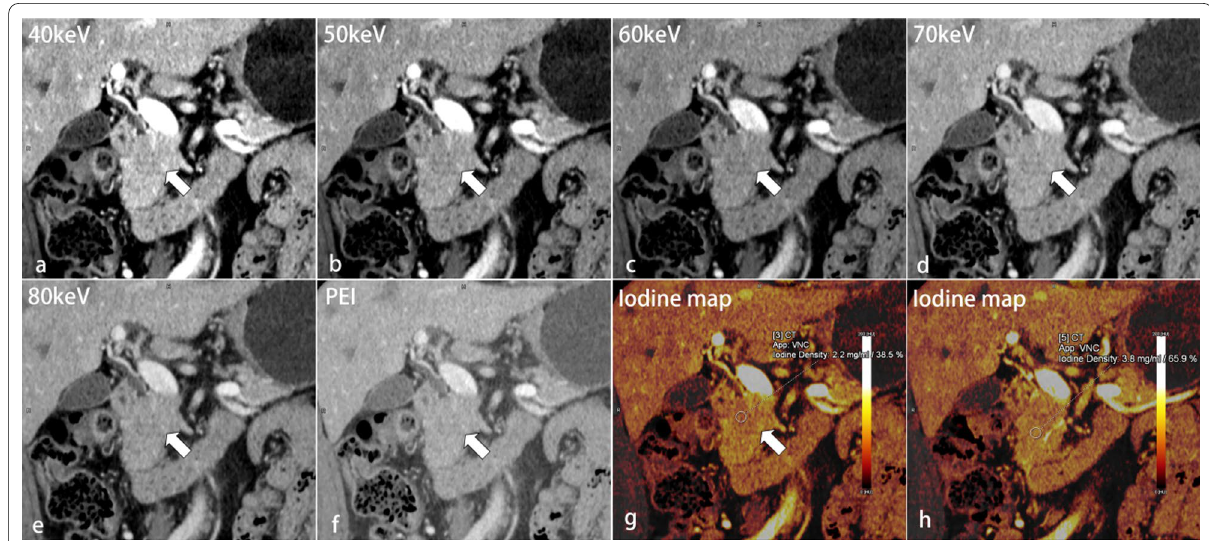
Fig. 6 Coronal reformatted image of a 66‑year‑old man with visually isoattenuating pancreatic ductal adenocarcinoma (PDAC) at the pancreatic head (arrows). Conventional polyenergetic image (PEI) revealed an isoattenuating mass, which was difficult to distinguish from the normal parenchyma ( f ). The 40‑keV MEI ( ) ( a ) showed the improvement of tumor conspicuity and margin delineation compared with 50–80 keV MEI + ( ) and PEI ( b – f ). On iodine maps ( g , h ), the NIC tumor value of 2.2 mg/mL confirmed the diagnosis of tumor, which was significantly lower than the + NIC parenchyma value of 3.8 mg/mL. Combining low‑keV MEI ( ) and iodine maps improved the tumor conspicuity of isoattenuating PDAC, possibly + enabling the early